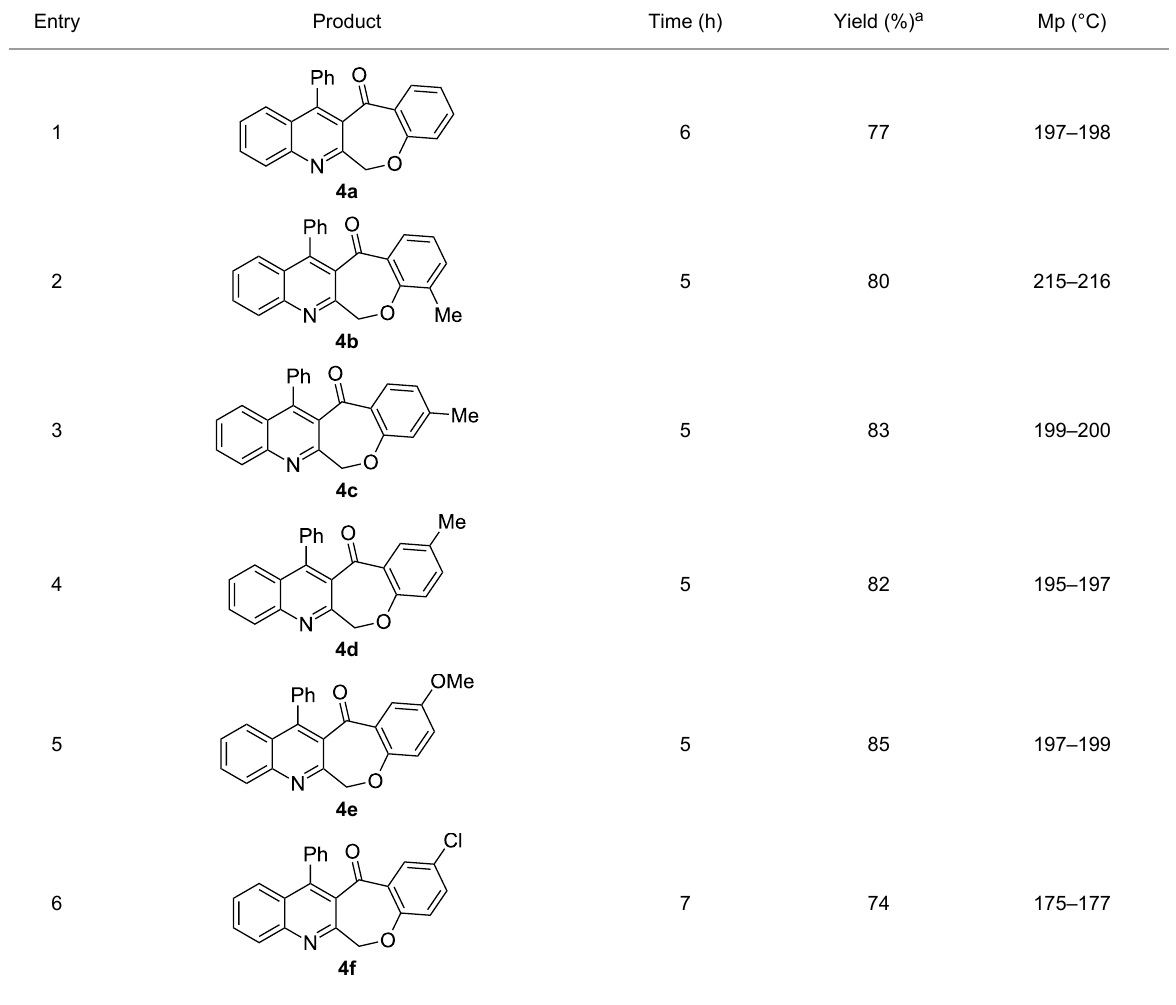
Table 2: Structures and yields of the cyclized products 4a – h